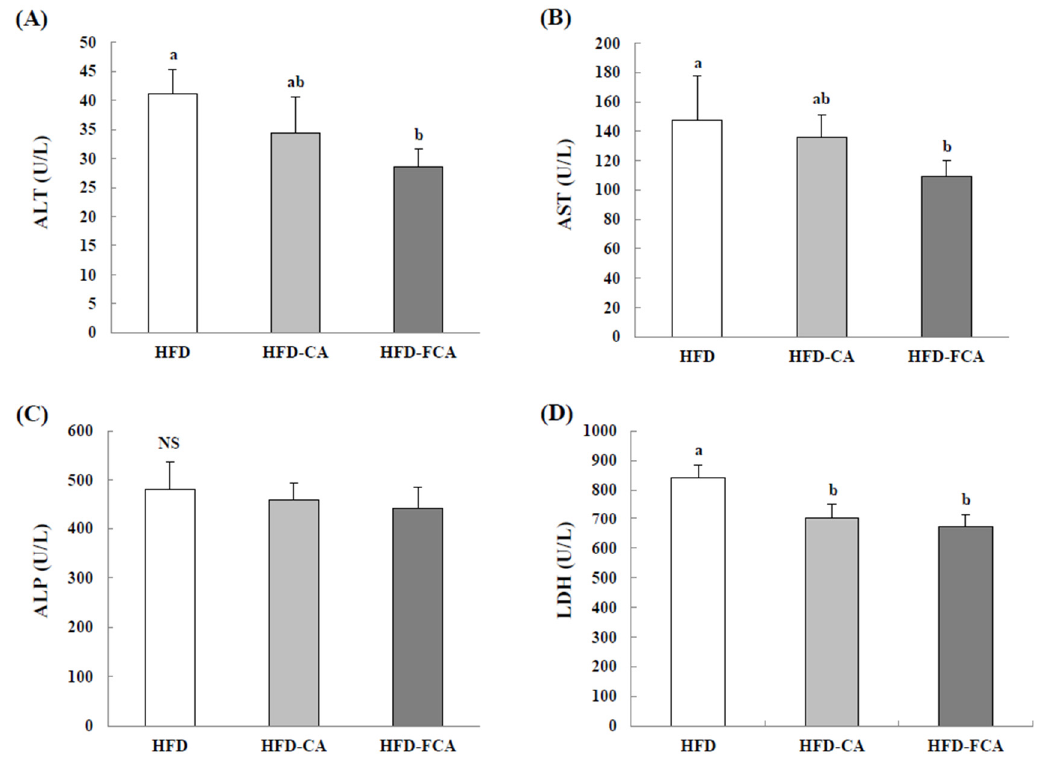
Figure 2. Serum alanine aminotransferase (ALT) ( A ), aspartate aminotransferase (AST) ( B ), alkaline phosphatase (ALP) ( C ), and lactate dehydrogenase (LDH) ( D ) activities in rats fed experimental diets for eight weeks. Values are mean ± SE ( n = 8). a,b; Bars with different letters are significantly different at p < 0.05 by Tukey’s test. NS: No significance. Diet groups; HFD, high fat diet group: HFD-CA, HFD + cabbage-apple juice administration group: HFD-FCA, HFD + fermented cabbage-apple juice administration group.